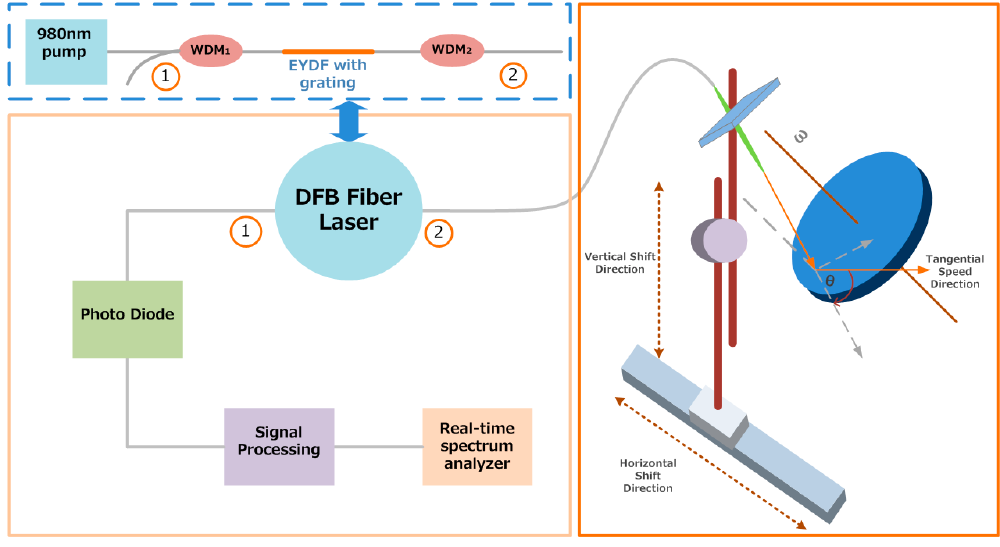
Figure 4. The experimental set-up of our novel all-fiber configuration SM-LDV based on the distributed feedback (DFB) fiber laser.